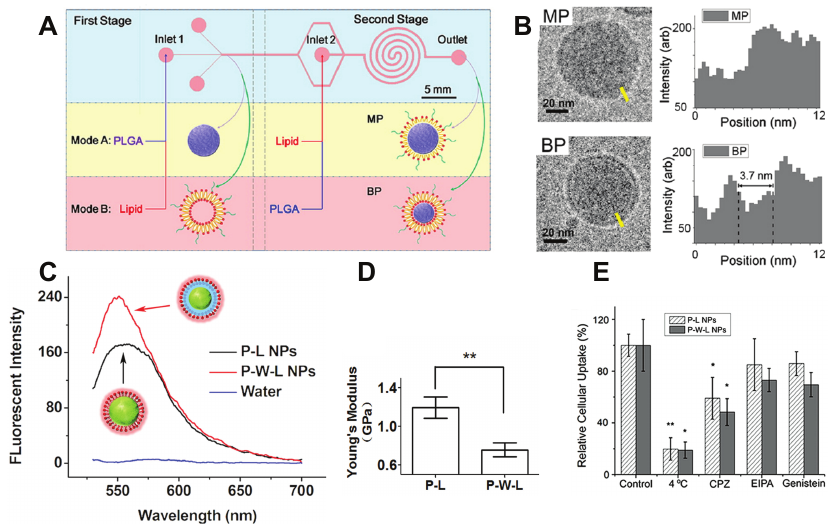
Figure 3. Structure difference in lipid molecule-decorated NPs and its effect on endocytosis. ( A ) Schematic of the two-stage-microfluidic platform; ( B ) Cryo-TEM images of monolayer shell lipid-polymer hybrid nanoparticles (MP P-L NPs) and bilayer shell lipid-polymer hybrid NPs (BP P-W-L NPs), the electron density showed that the BPs had a lipid bilayer. While the MPs have only one layer of lipids; ( C ) Plot of the fluorescence emission spectrum of BPs and MPs. It suggests that the BPs contain more water; ( D ) Plot of the Young’s moduli for MPs and BPs. MPs had higher Young’s modulus than the BPs with same size of 40 nm in diameter; E : The HeLa cells had a higher uptake of MPs than BPs. Chlorpromazine (CPZ), Ethylisopropyl amiloride (EIPA), and Genistein are used for inhibiting clathrin-mediated endocytosis, macropinocytosis, and caveolae-mediated endocytosis, respectively. The figures are adapted from References [50,51] with